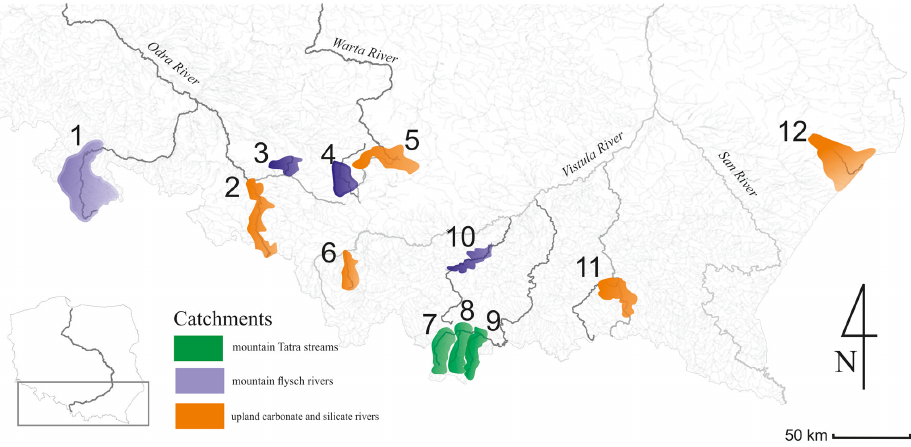
Figure 1. Map of the studied mountainous rivers in the Carpathian–Sudetian region of Poland. Table 1. Mean values ± standard deviation of the physicochemical and habitat variables of the three river groups, with results of one-way ANOVA. Items in bold indicate statistically significant